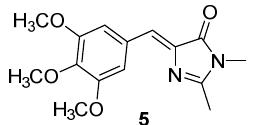
Figure 5. GFPc analogue emitting in the solid state, at different wavelengths depending on the polymorph [19].